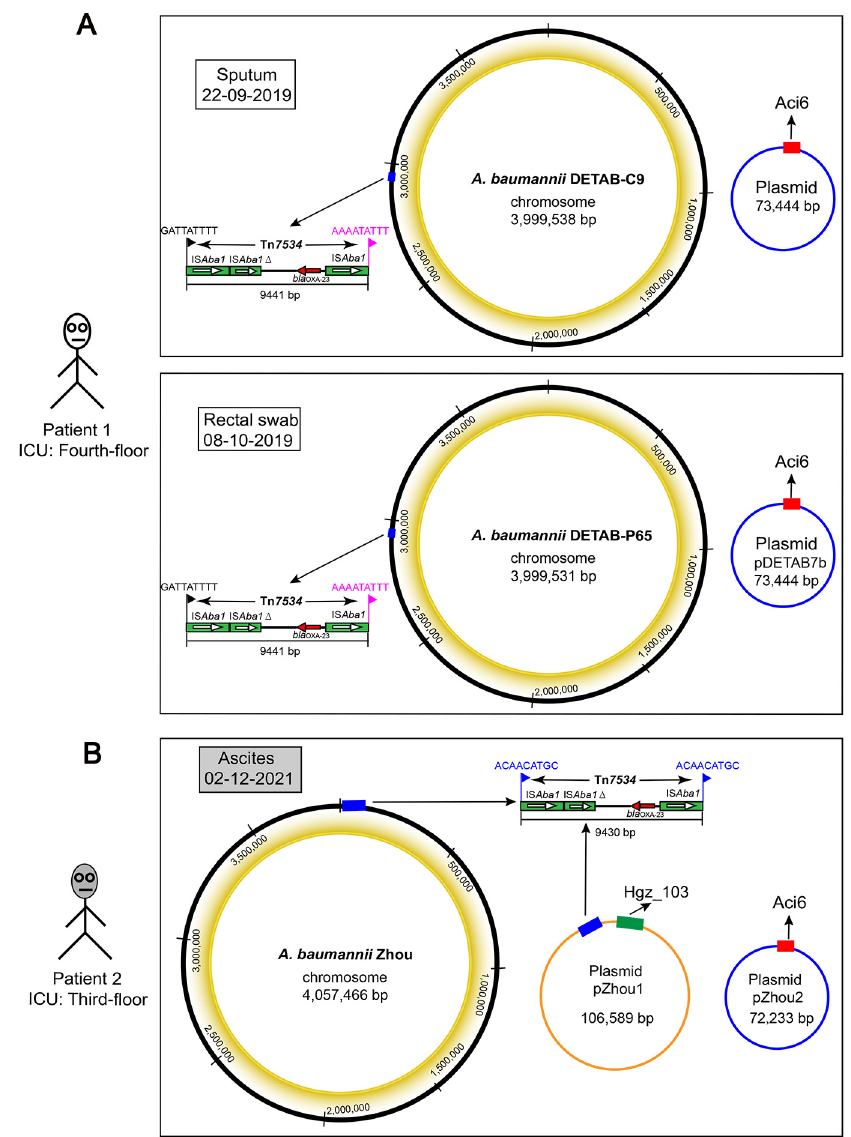
Figure 1. A. baumannii strains and genomic information. ( A ) A. baumannii DETAB-C9 and DETAB-P65 were collected from the sputum and rectal swab of patient 1 (upper white cartoon character) on the fourth floor of the ICU. Circular maps of the chromosome and plasmid are shown using black and blue circles, respectively. The position of novel transposon Tn 7534 is indicated by the blue box, and its specific structure is drawn with 9 bp target site duplications (TSDs) indicated using different-colored flags based on the TSD sequence. ( B ) The A. baumannii ZHOU strain was collected from ascites of patient 2 (lower grey cartoon character) on the third floor of the ICU in the same hospital. Circular maps of the chromosome and plasmid are also shown. The Hgz_103-type plasmid is indicated by an orange circle. Two copies of Tn 7534 transposon are indicated by a blue box with 9 bp identical TSDs (ACAACATGC) on either